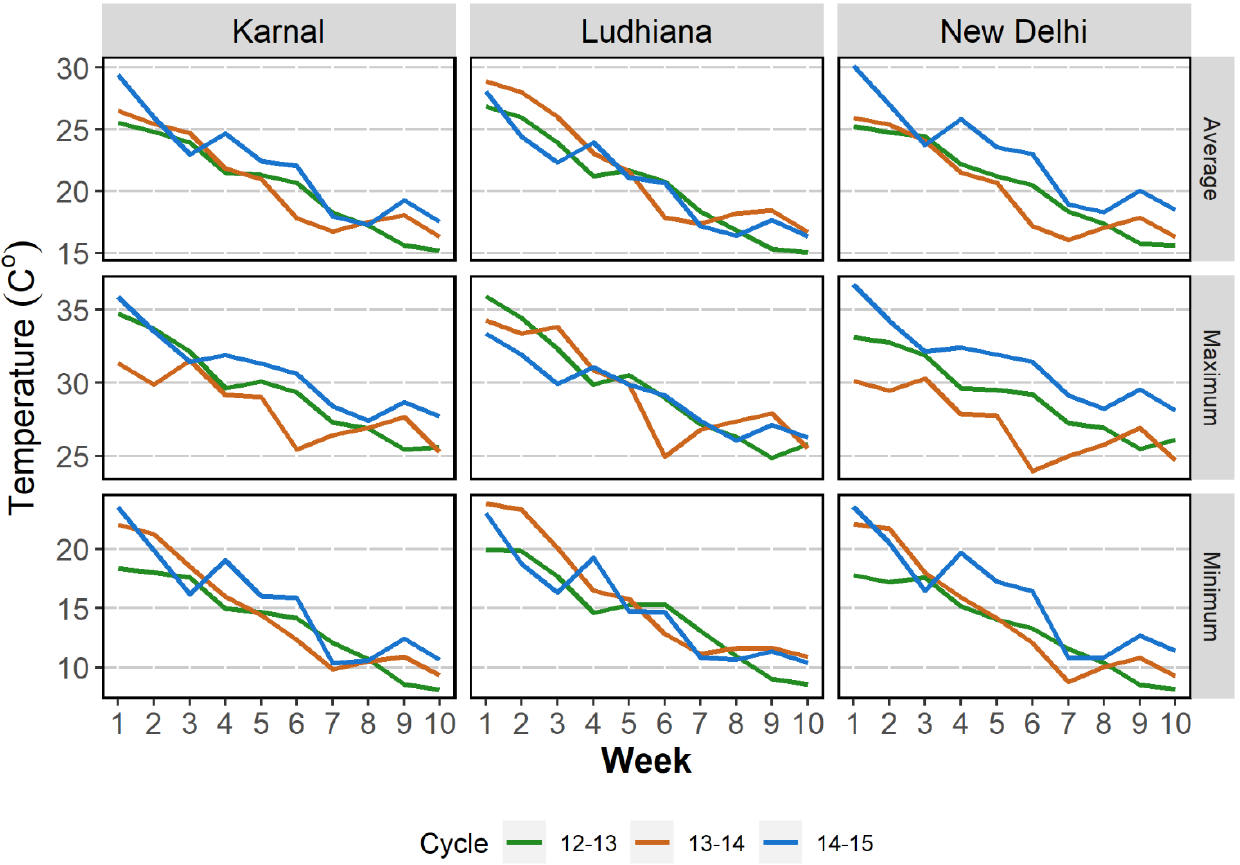
Figure 1. Weather parameters in the three (2012–2015) years of testing in northwest India.